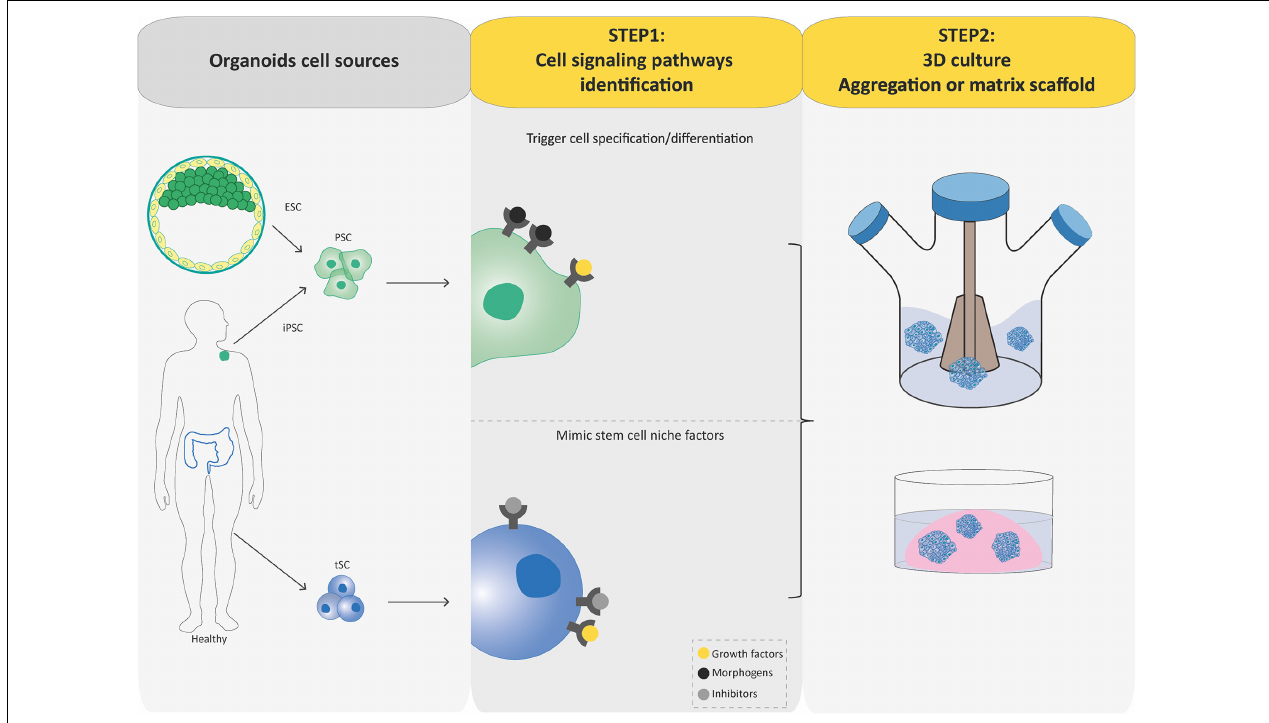
FIGURE 2 | Flowcharts of the establishment of pluripotent stem cell (PSC)-derived and tissue-specific stem cell (tSC)-derived organoids. Organoids can be established from PSCs (iPSCs and ESCs) or tissue-specific SCs (tSCs; left-hand box). Two key steps are involved in PSC-derived and tSC-derived organoid production. First (central box), the identification of crucial cell signaling pathways allowing directed differentiation (combinations of morphogens and growth factors) and/or to establish a permissive environment for the stem cell culture by mimicking their in vivo niche (specific growth factors and inhibitors). Second (right-hand box), cultures are grown so as to favor their expansion in three dimensions, which is achieved either by aggregating cells into 3D structures or by embedding the cultures into a 3D matrix